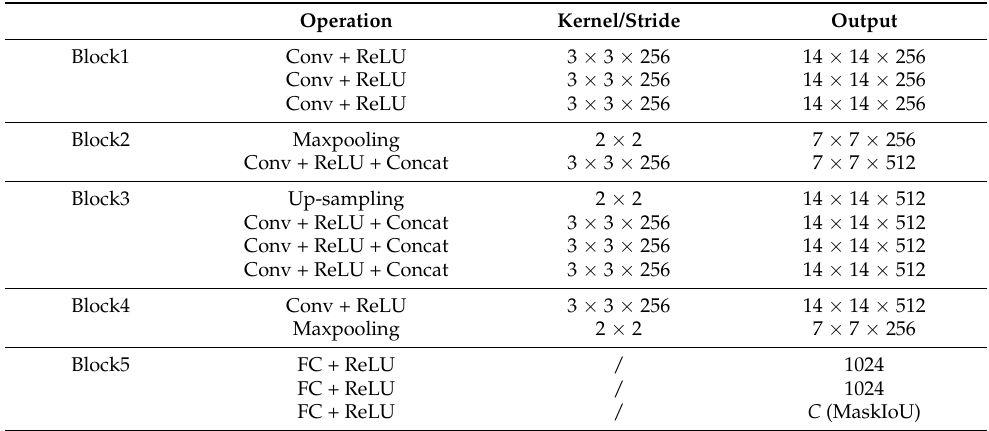
Table 2. The details of the proposed MaskIoU branch with U-shaped network. C represents the number of classes in the